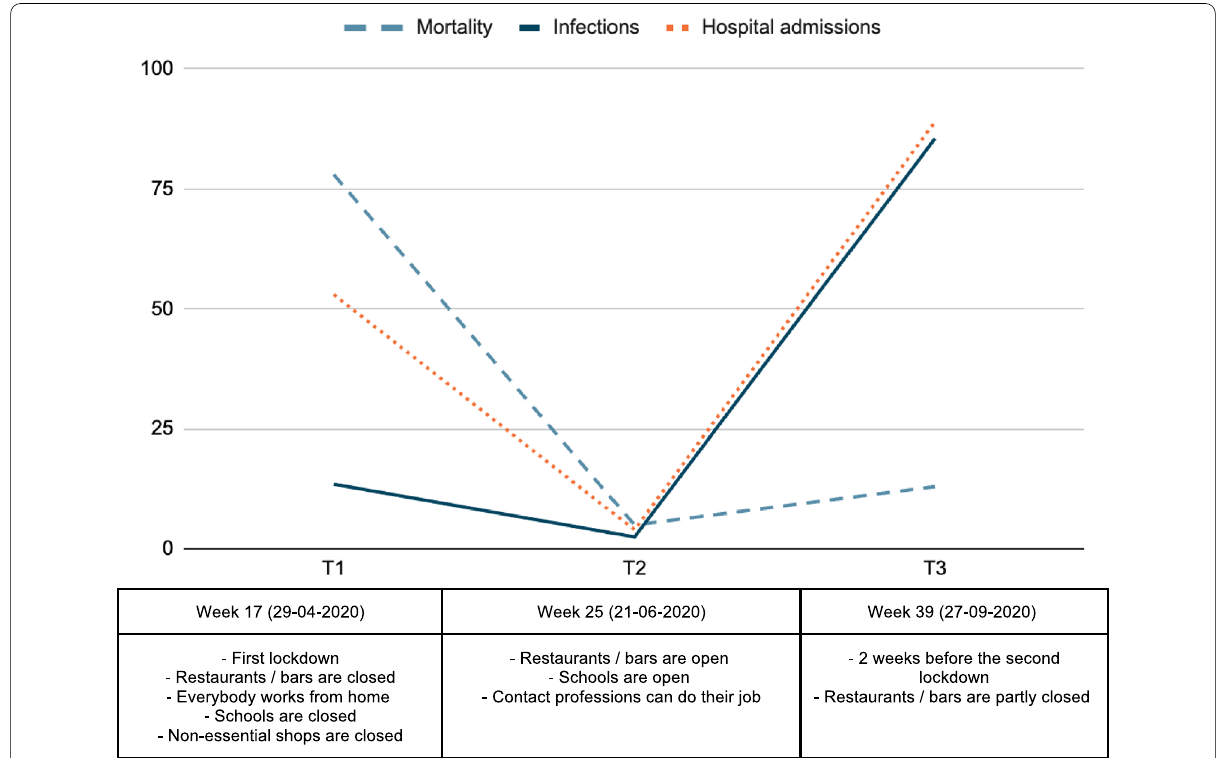
Fig. 1 The number of hospital admissions and mortality during the COVID-19 pandemic in the Netherlands at T1, T2, and T3 (source: RIVM, 2021).